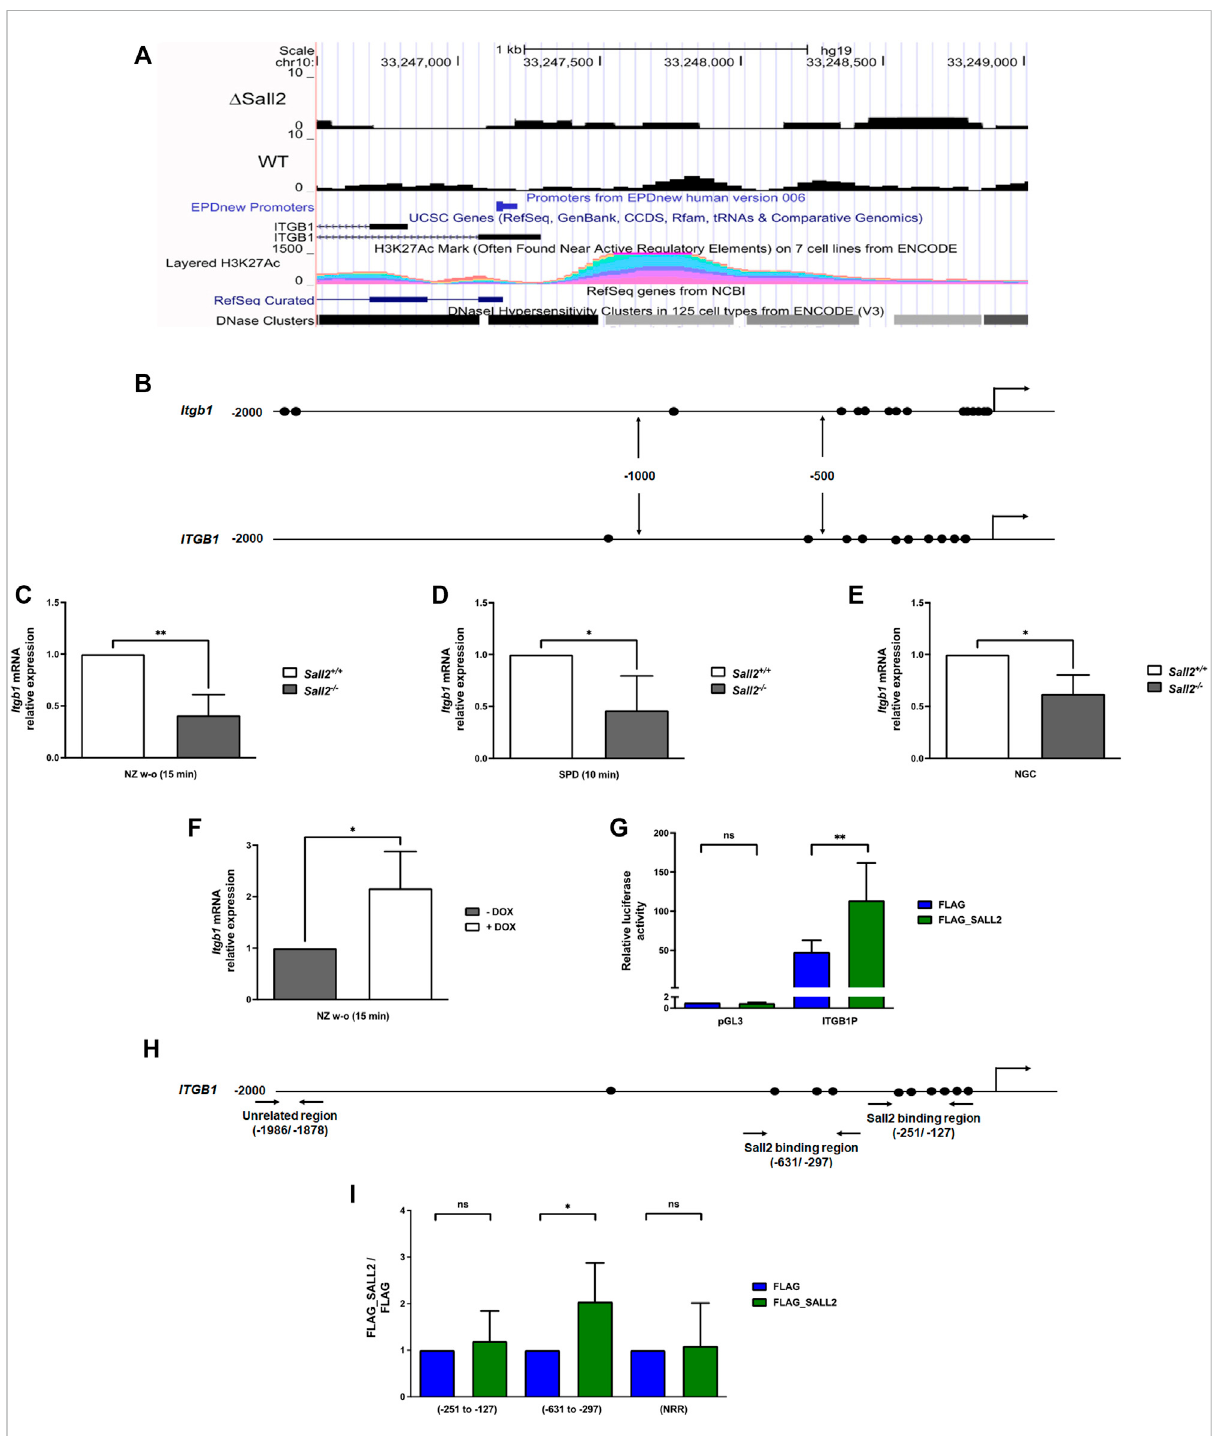
FIGURE 6 Sall2transcriptionallyregulatesintegrin β 1. (A) Bigwigtrackfrom ITGB1 gene,accordingtoreferencefromNCBIRefSeqgenesandUCSC genes (ENCODE), from SALL2 wild-type (WT) and SALL2 knockout HEK293 cells ( Δ Sall2) ChIP-seq datasets. SALL2 binding enrichment and associated peaks in the promoter region, according with EPDnew Promoters ENCODE data are shown. H3K27Ac enhancer mark and DNase Clusters from ENCODEarealsoshown,plottedwiththeUCSCgenomebrowser(https://genome.ucsc.edu/,hg19track). (B) Schematicrepresentationofmouse and human integrin β 1 ( Itgb1/ITGB1 ) promoters. The putative SALL2/Sall2 binding sites are represented by black ovals. The transcription start site (+1) is represented by arrows. (C – E) Integrin β 1 mRNA level from Sall2 +/+ and Sall2 − / − iMEFs were determined by real-time PCR after 15 min of nocodazole wash-outtreatment(NZ w-o) (C) , 10 min ofspreading (SPD) onFN (D) and under normal growth conditions (NGC) (E) . (F) Integrin β 1 mRNAlevels